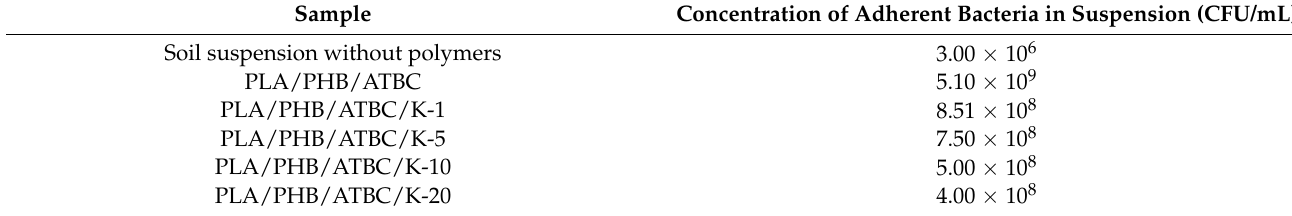
Table 4. Concentration of bacteria microorganisms over the PLA/PHB/ATBC polymer blend and its keratin composites with different keratin contents varying from 1 to 20